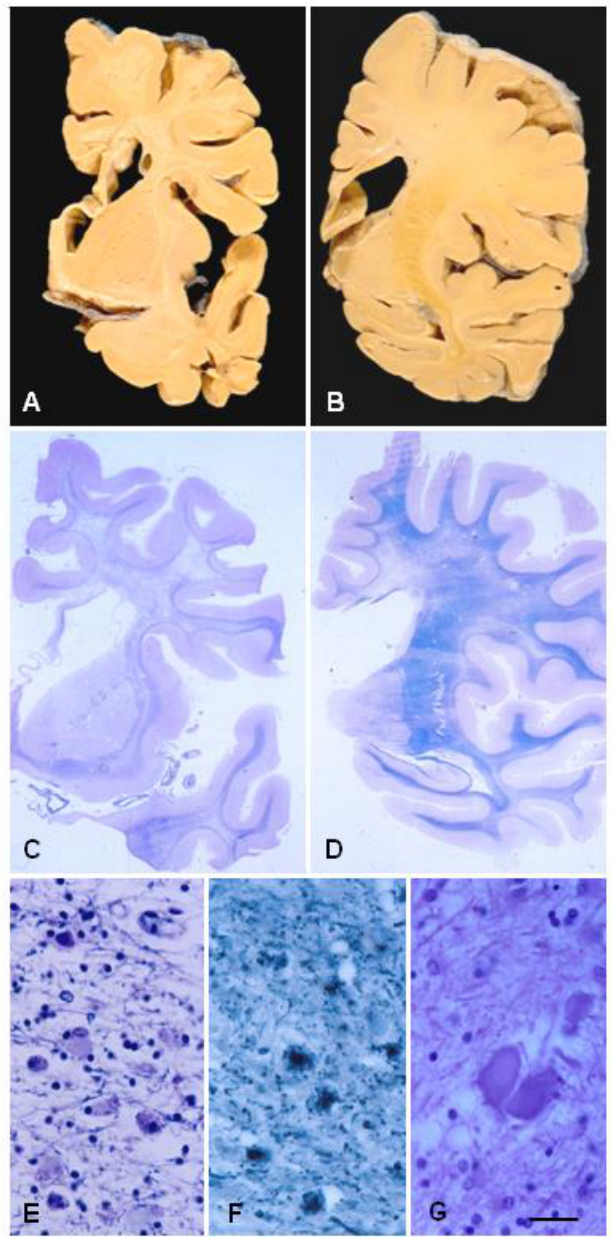
Figure 1. ALSP. ( A , B ) Coronal sections of the brain showing atrophy of the cerebral white matter more markedly in the anterior poles than in the posterior regions, atrophy of the corpus callosum, and enlargement of the lateral ventricles. ( C , D ) Hemispheric sections stained with Klüver–Barrera showing severe myelin loss of the centrum semi-ovale, corpus callosum, and internal capsule, and preservation of the short cortico-subcortical U-fibres. ( E , F ) Astrocytic gliosis and macrophages filled with pigment in the affected white matter. ( G ) Axonal ballooning. Paraffin sections, ( E – G ), bar = 25 μm.